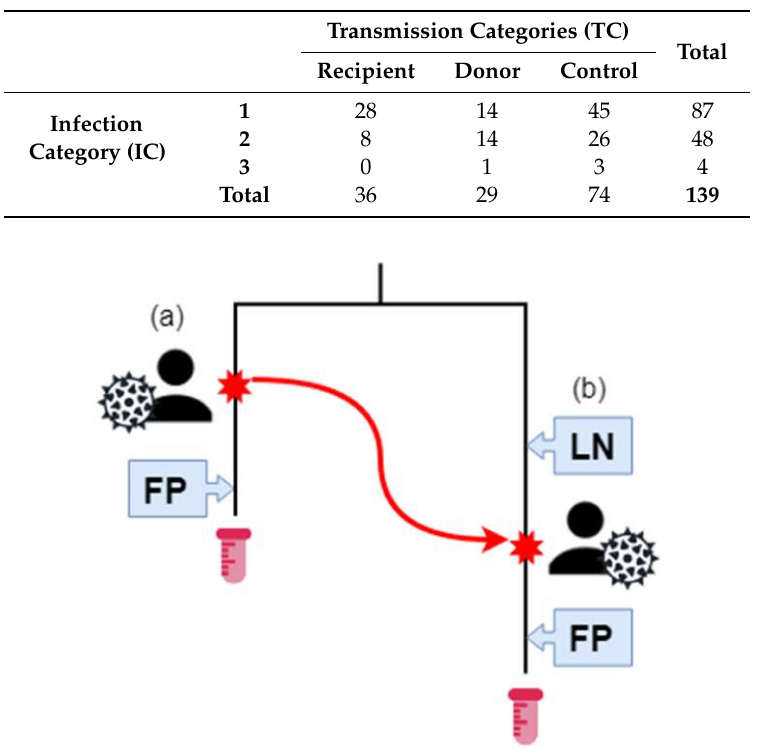
Table 1. Breakdown of the number of patients based on their clinical data completeness.